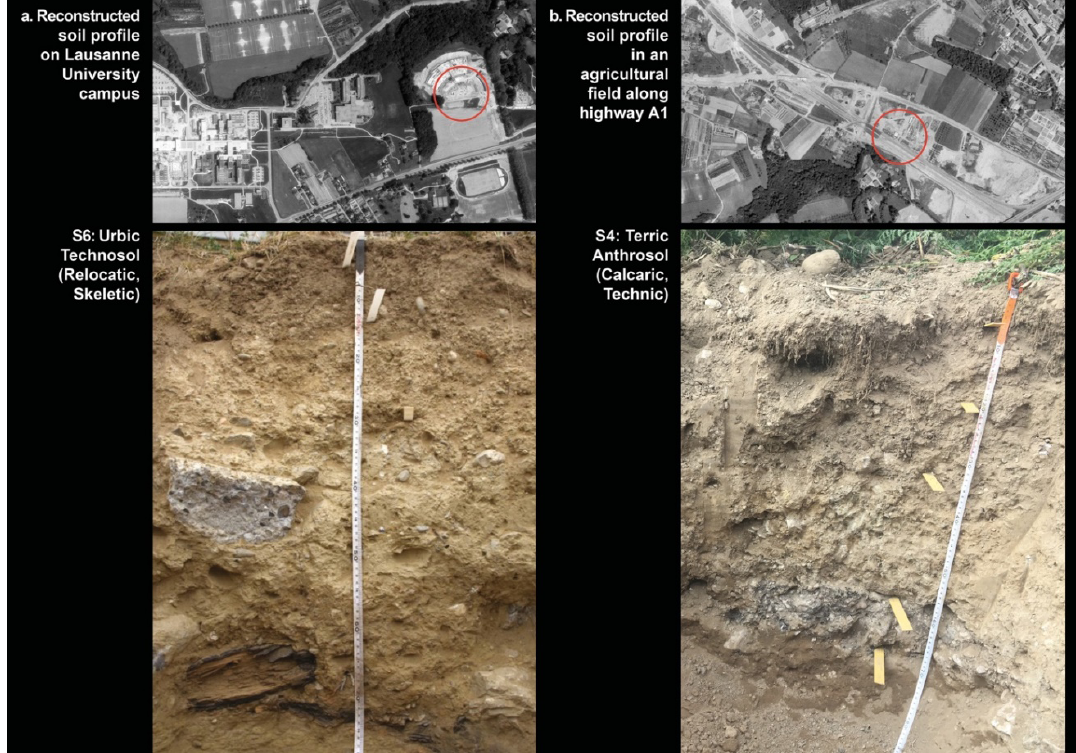
Figure 11. Second half of the 20th century: Soil profiles, accompanied by historical source documents illustrating the ur- banization processes which produced them. Source: Authors, based on photos and archival sources provided by Swisstopo, and UNIL–UNINE Biogeoscience Master’s Degree, Fall